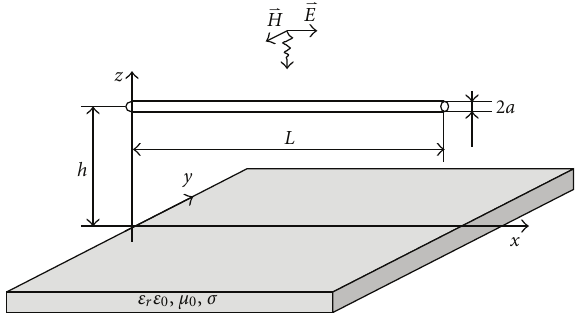
Figure 3: Horizontal wire above a lossy ground.